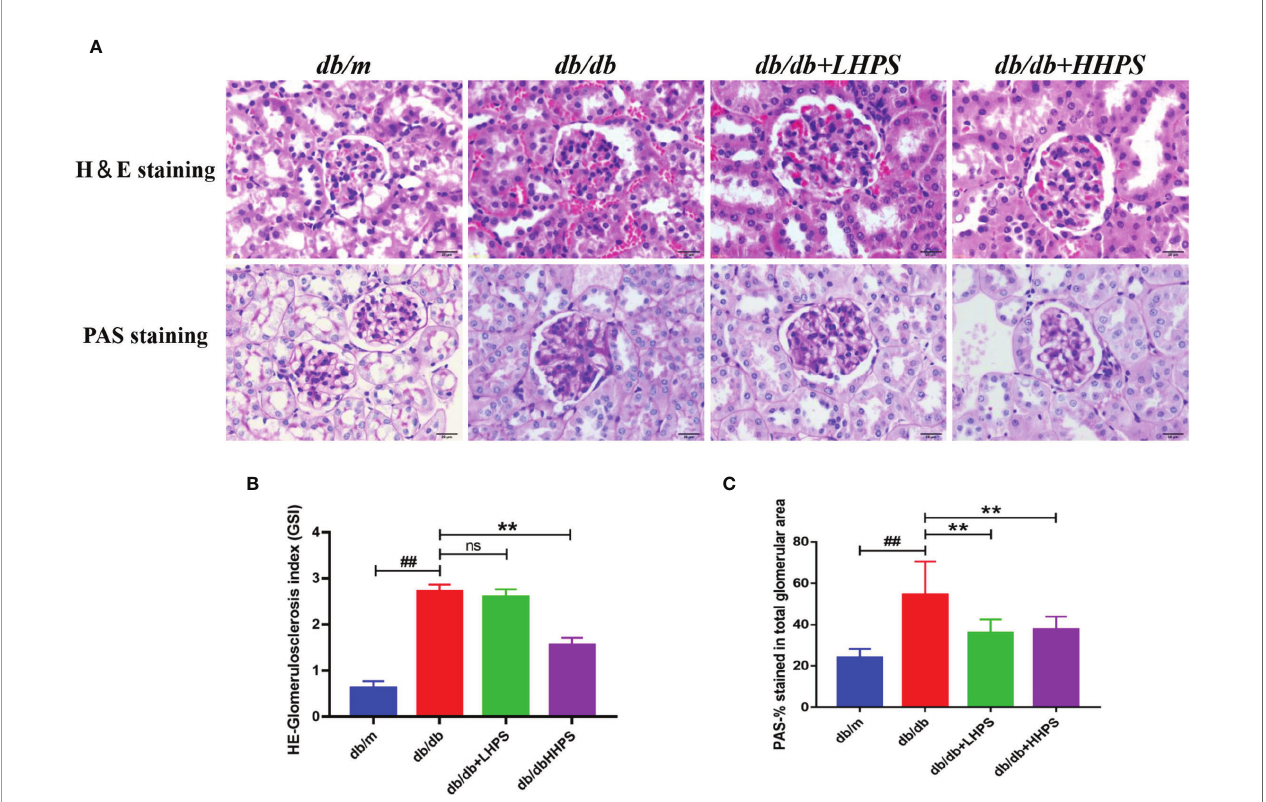
FIGURE 2 | Hyperoside ameliorates mesangial matrix expansion in glomeruli of db/db mice. The db/db mice were treated with HPS, while control mice receiving vehicle treatment were administered with the same volume of vehicle used to prepare HPS. (A) Renal morphology was analyzed by H&E staining on kidney sections while glomerular mesangial matrix fractions and glomerulosclerosis were analyzed using PAS staining in mice at the age of 12 weeks. Figures for representative sections are shown at ×400 magni fi cation. (B) Shown is quanti fi cation of the glomerulosclerosis index (GSI) for each group. (C) The PAS stained areas for each group are also quanti fi ed. Values (mean ± SD) were obtained from 3 animals in each group (n=3 per group). Differences between experimental groups were evaluated using ANOVA ( ## P < 0.01 vs db/m ; ** P < 0.01 vs db/db; ns, not signi fi cant). db/m , non-diabetic normal mice; db/db , diabetic nephropathy mice; db/db +LHPS, diabetic nephropathy group mice treated with a low dose of HPS; db/db +HHPS, diabetic nephropathy group mice treated with a high dose of HPS; H&E, Hematoxylin and Eosin; PAS, Periodic Acid –